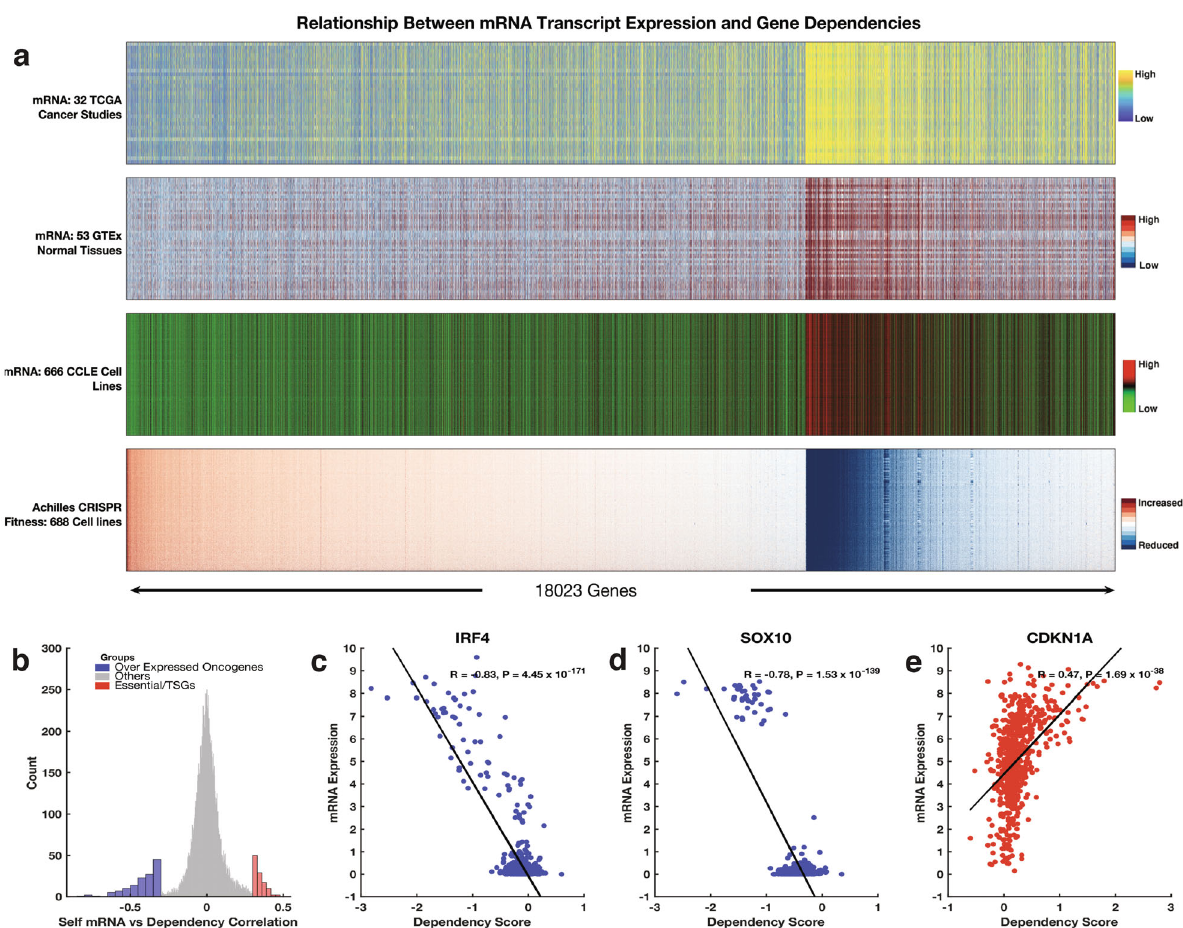
Fig. 5 Relationship between Achille gene dependence scores and the mRNA transcriptional abundance of all the protein-coding genes. a Integrated plot showing the relationship between CRISPR-derived gene dependence scores for over 18,000 protein-coding genes and the mRNA transcript levels of these genes. From top to bottom: mRNA transcript levels of 10,534 primary tumour samples pro fi le by the TCGA pan-cancer project; mRNA transcript levels of 53 non-diseased tissue sites measured in nearly 1000 individuals by the GTEx consortium; mRNA transcript levels of 667 cell lines pro fi led by the CCLE; Achilles CRISPR knockout fi tness screens of 688 cell lines. b Histogram showing the overall correlation between gene dependence and the gene ’ s self-mRNA levels. To aid visualisation, we used a bin size of 300 for genes (shown as “ other genes ” ) that showed a Pearson ’ s correlation coef fi cient between − 0.3 and 0.3. In contrast, we used a bin size of 10 for the genes that showed a Pearson ’ s correlation coef fi cient of < − 0.3 and or >0.3. Correlation between gene dependence and the gene ’ s self-mRNA levels for c IRF4 transcription factor, d SOX10 transcription factor, and e the CDKN1A